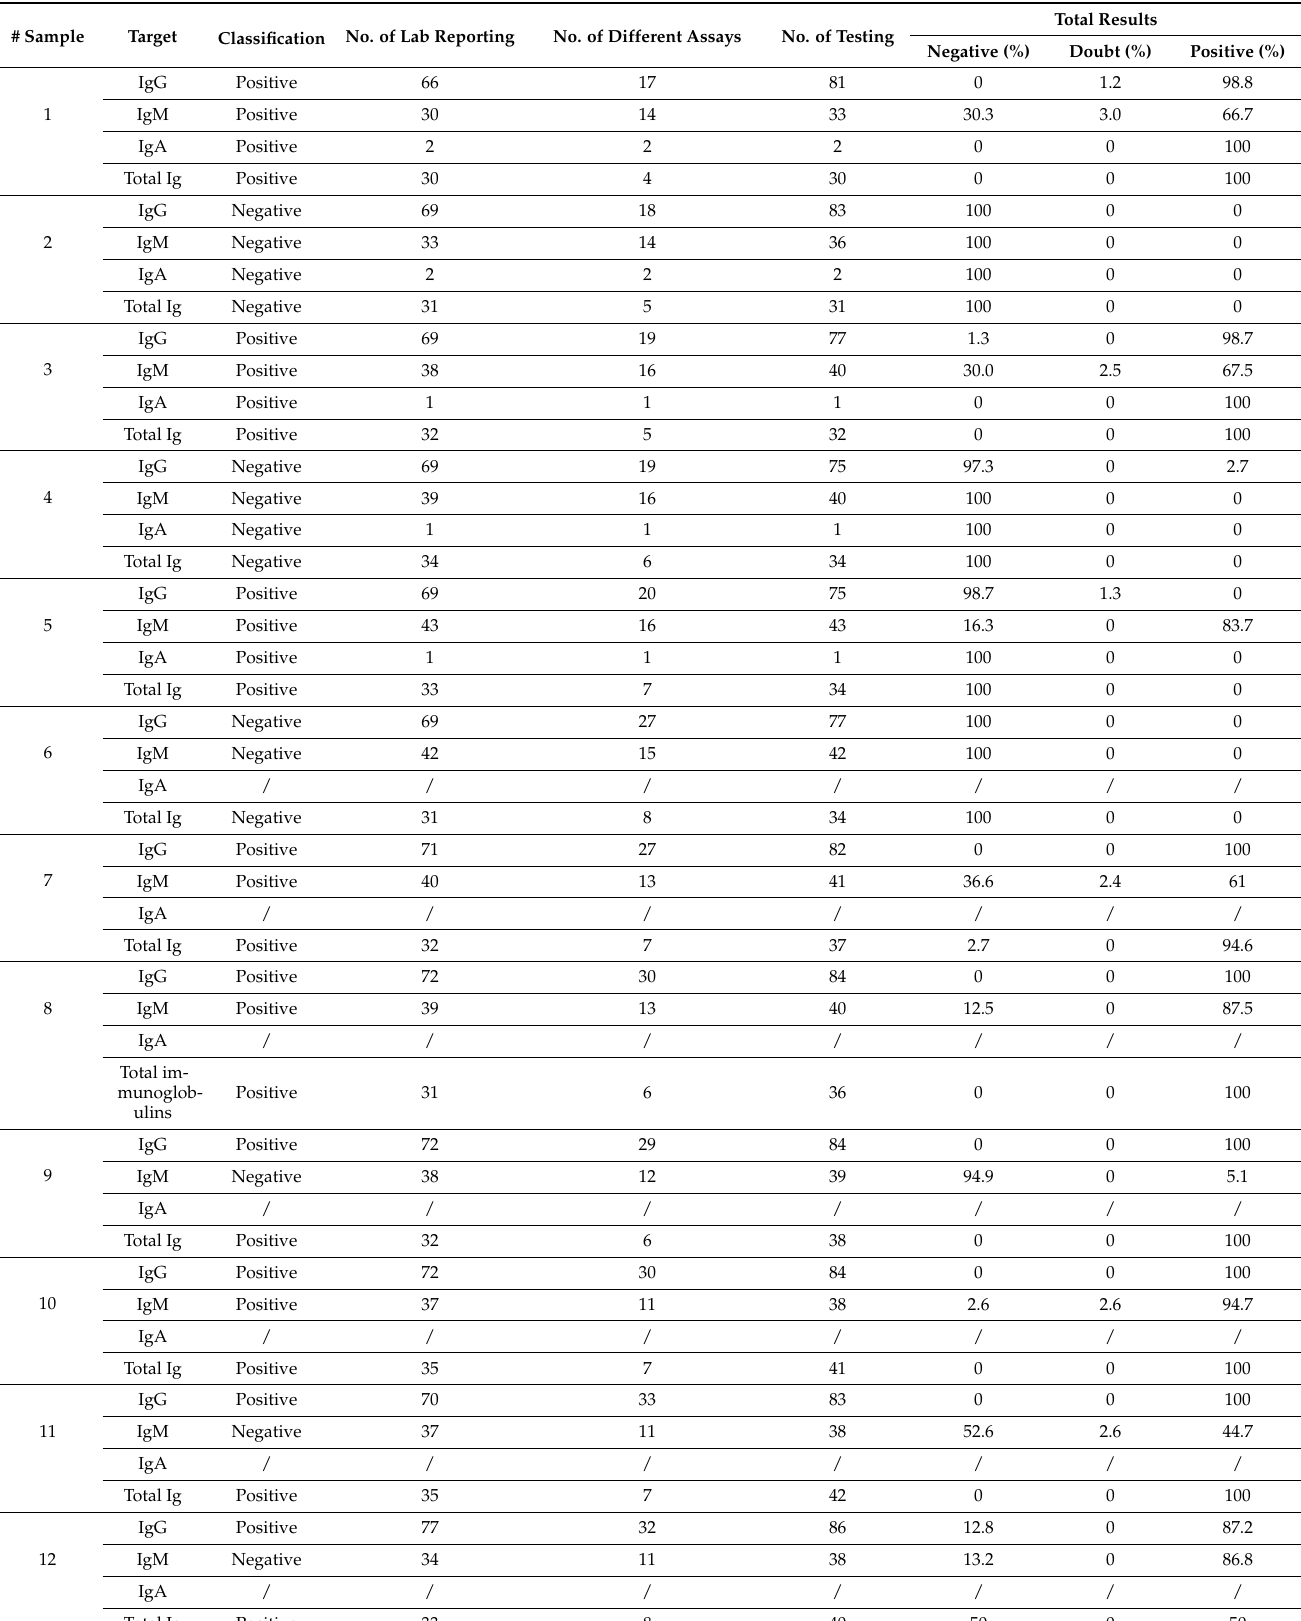
Table 2. Number of laboratories reporting, number of assays, number of reported testing and results of the anti-SARS-CoV-2 antibody